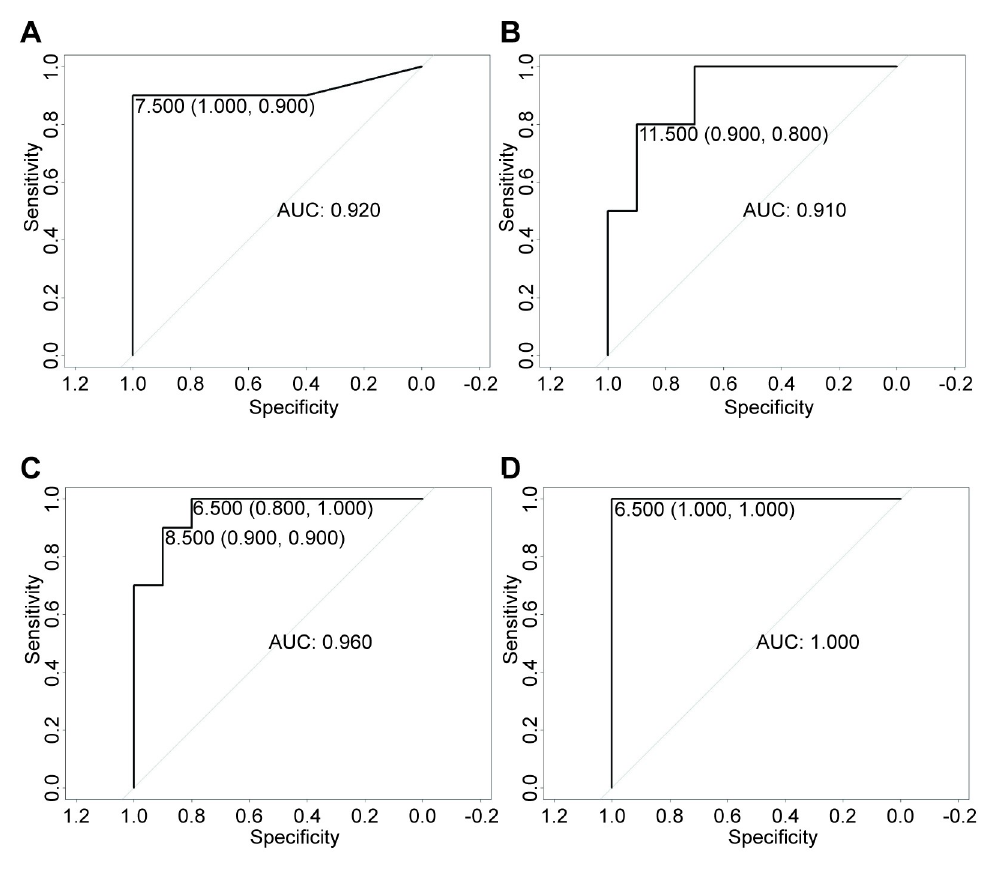
Fig 4. ROC analysis of miRNA. A: ROC analysis hsa-mir-338. B: ROC analysis hsa-mir-30a. C: ROC analysis hsa-mir-451a. D: ROC analysis hsa-mir-4732. The AUC > 0.8 of the selected miRNA indicates that the result is meaningful.